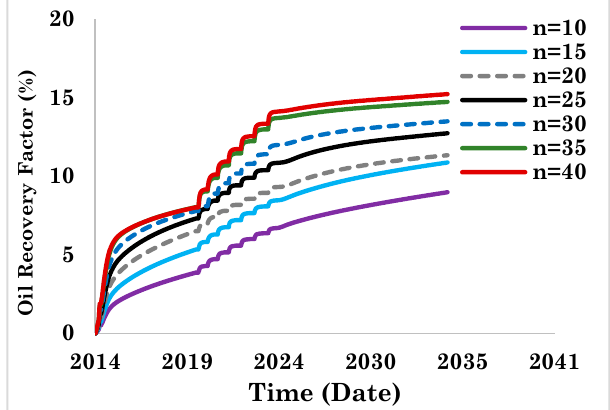
Figure 20. NG Injection (Fixed Cycle Size) 31 API Oil.